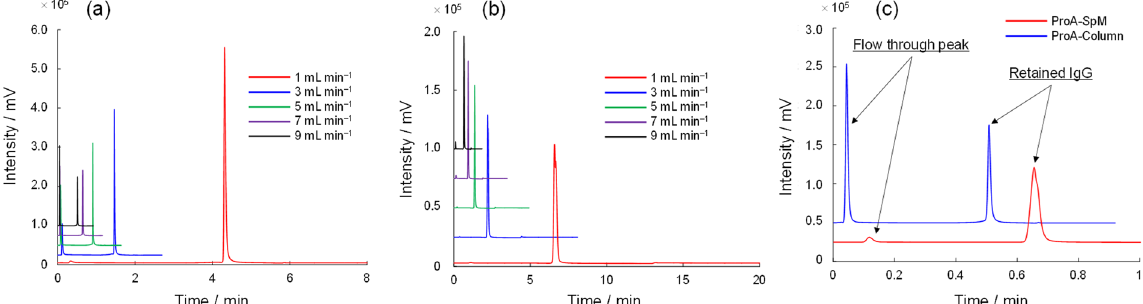
Figure 3. The UV chromatograms for IgG on protein A immobilized column under various flow rates. Affinity separations with a various flow rates with the ProA-Column ( a ) and ProA-SpM ( b ). ( c ) Rapid separation of IgG from a protein A load sample with the ProA-Column or ProA-SpM at 9.0 mL min − 1 .